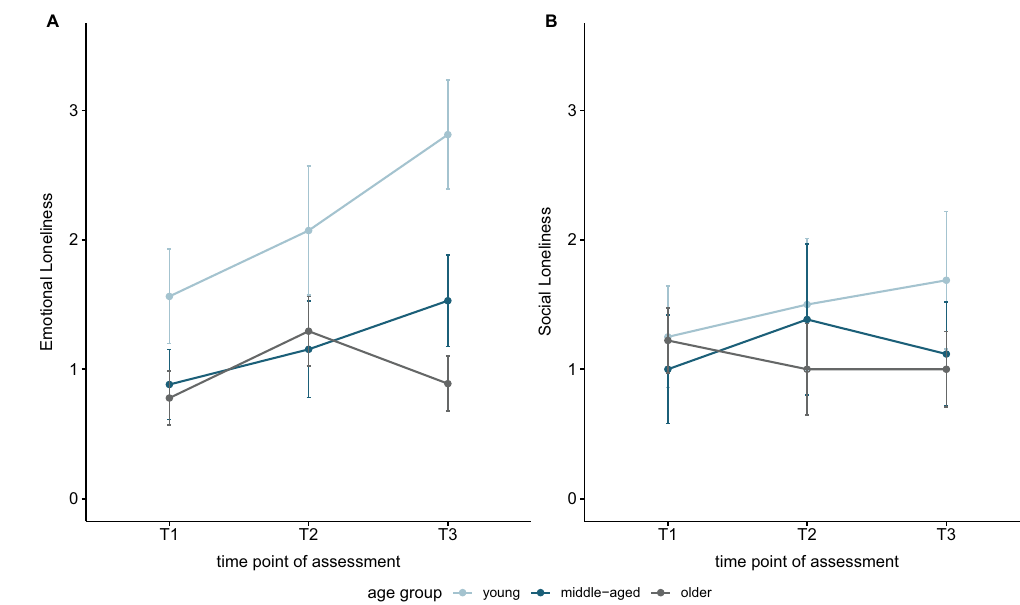
Figure 2. Emotional and social loneliness scores for different age groups across time. Loneliness was assessed by a German version of the 11-items Loneliness Scale by De Jong and Gierveld, which offers a distinction between emotional and social loneliness. Emotional loneliness describes the perceived lack of intimacy in interpersonal relations, whereas social loneliness refers to a lack of a broad social network. Participants gave their answers on a 5-point frequency scale. Emotional loneliness scores can range between 0 and 6, social loneliness scores can range between 0 and 5, with higher scores representing higher perceived emotional or social loneliness respectively. Error bars depict 1 standard